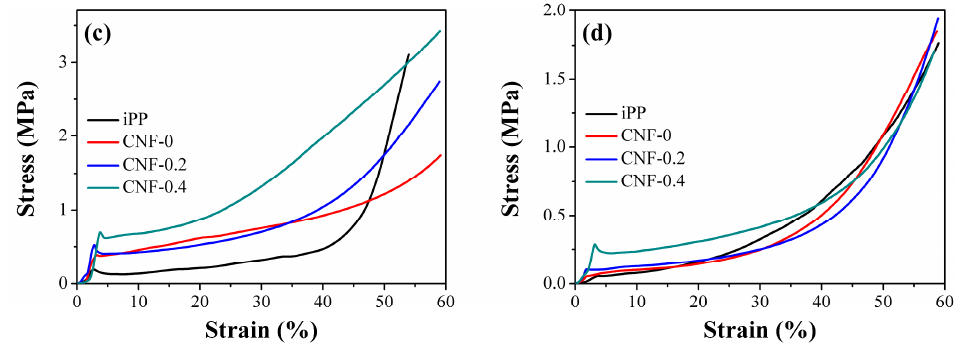
Figure 9. Characteristic stress − strain curves for foamed iPP and PP/CNF nanocomposites at the expansion ratios of: ( a ) 2-fold; ( b ) 5-fold; ( c ) 7-fold; and ( d ) 10-fold, respectively.